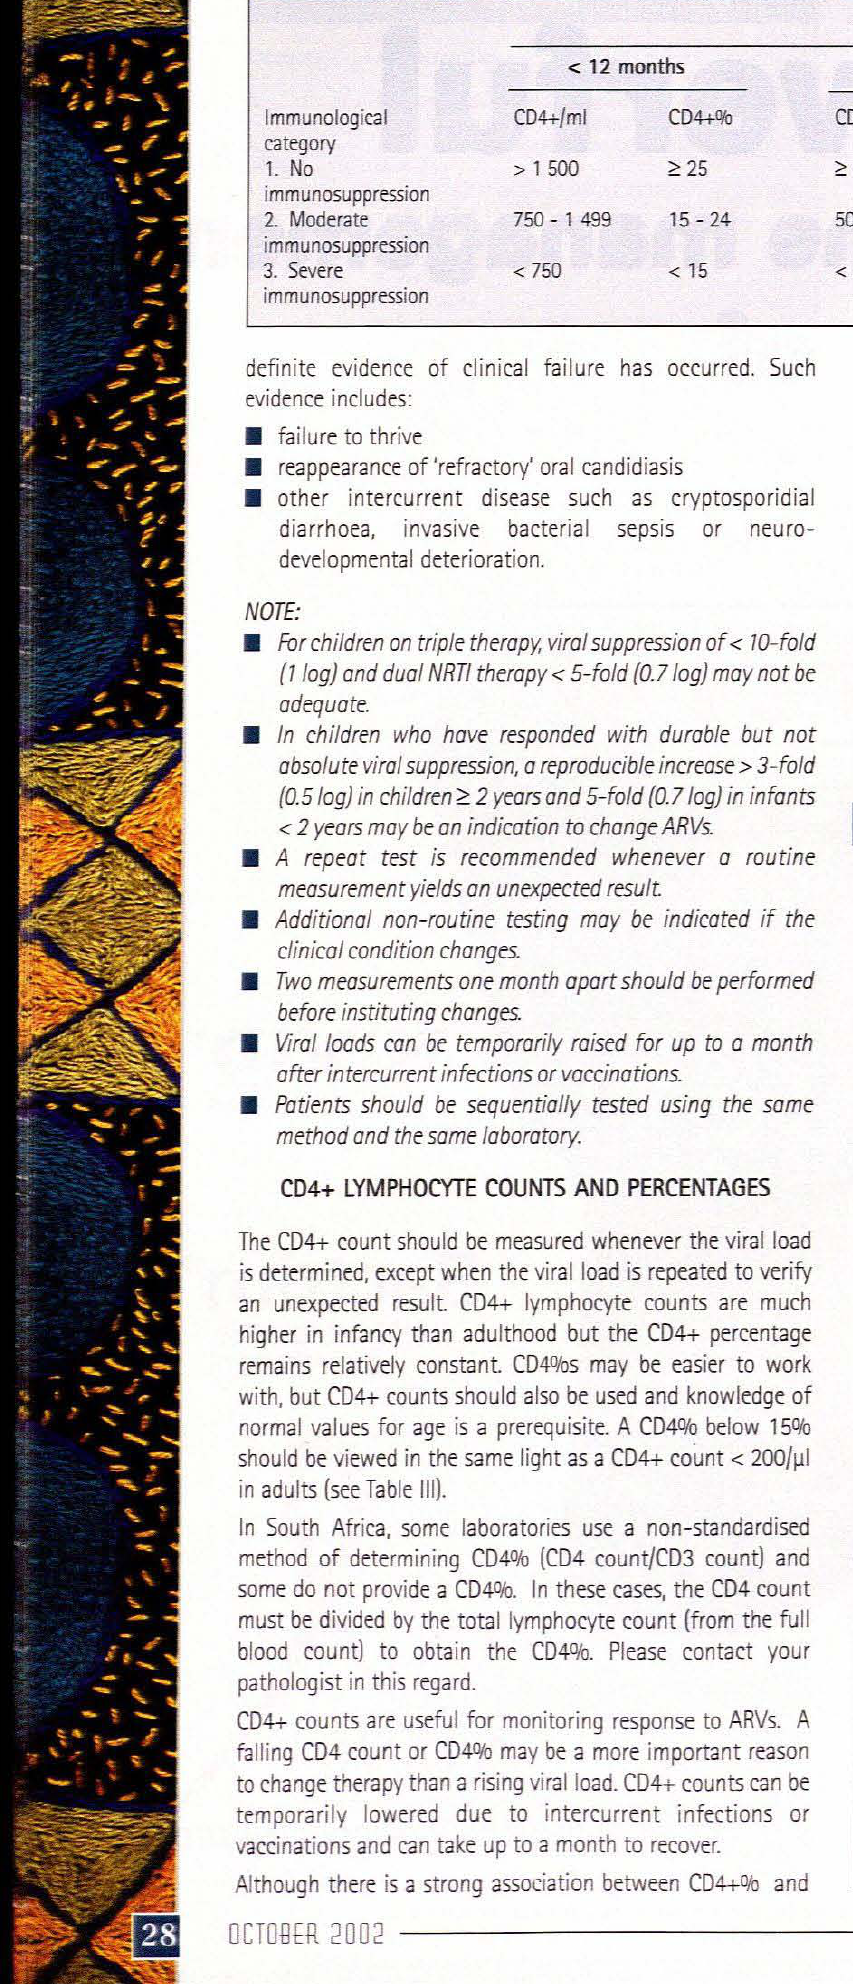
TABLE Ill. IMMUNOLOGICAL CATEGORIES FOR CHILDREN WITH HIV INFECTION